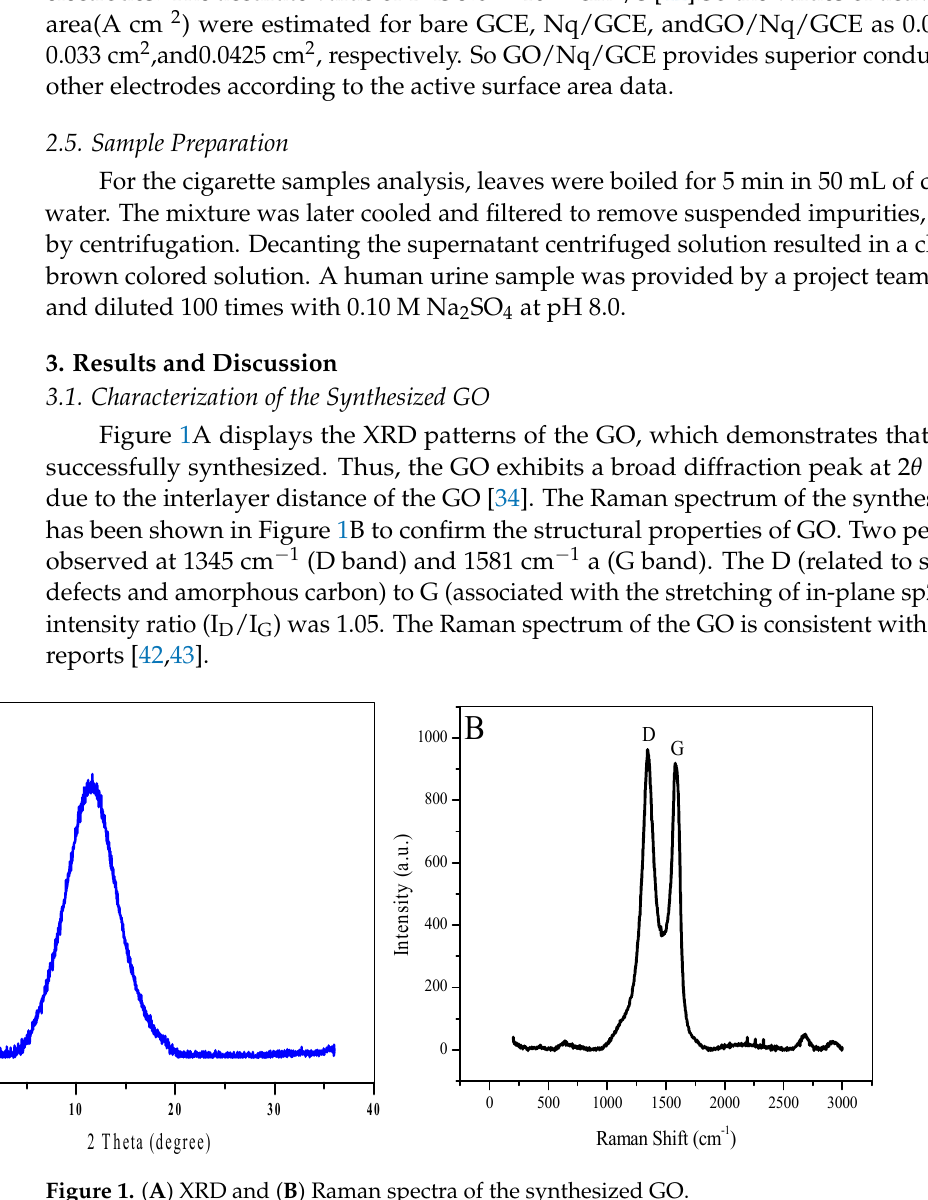
Figure 1. ( A ) XRD and ( B ) Raman spectra of the synthesized GO.